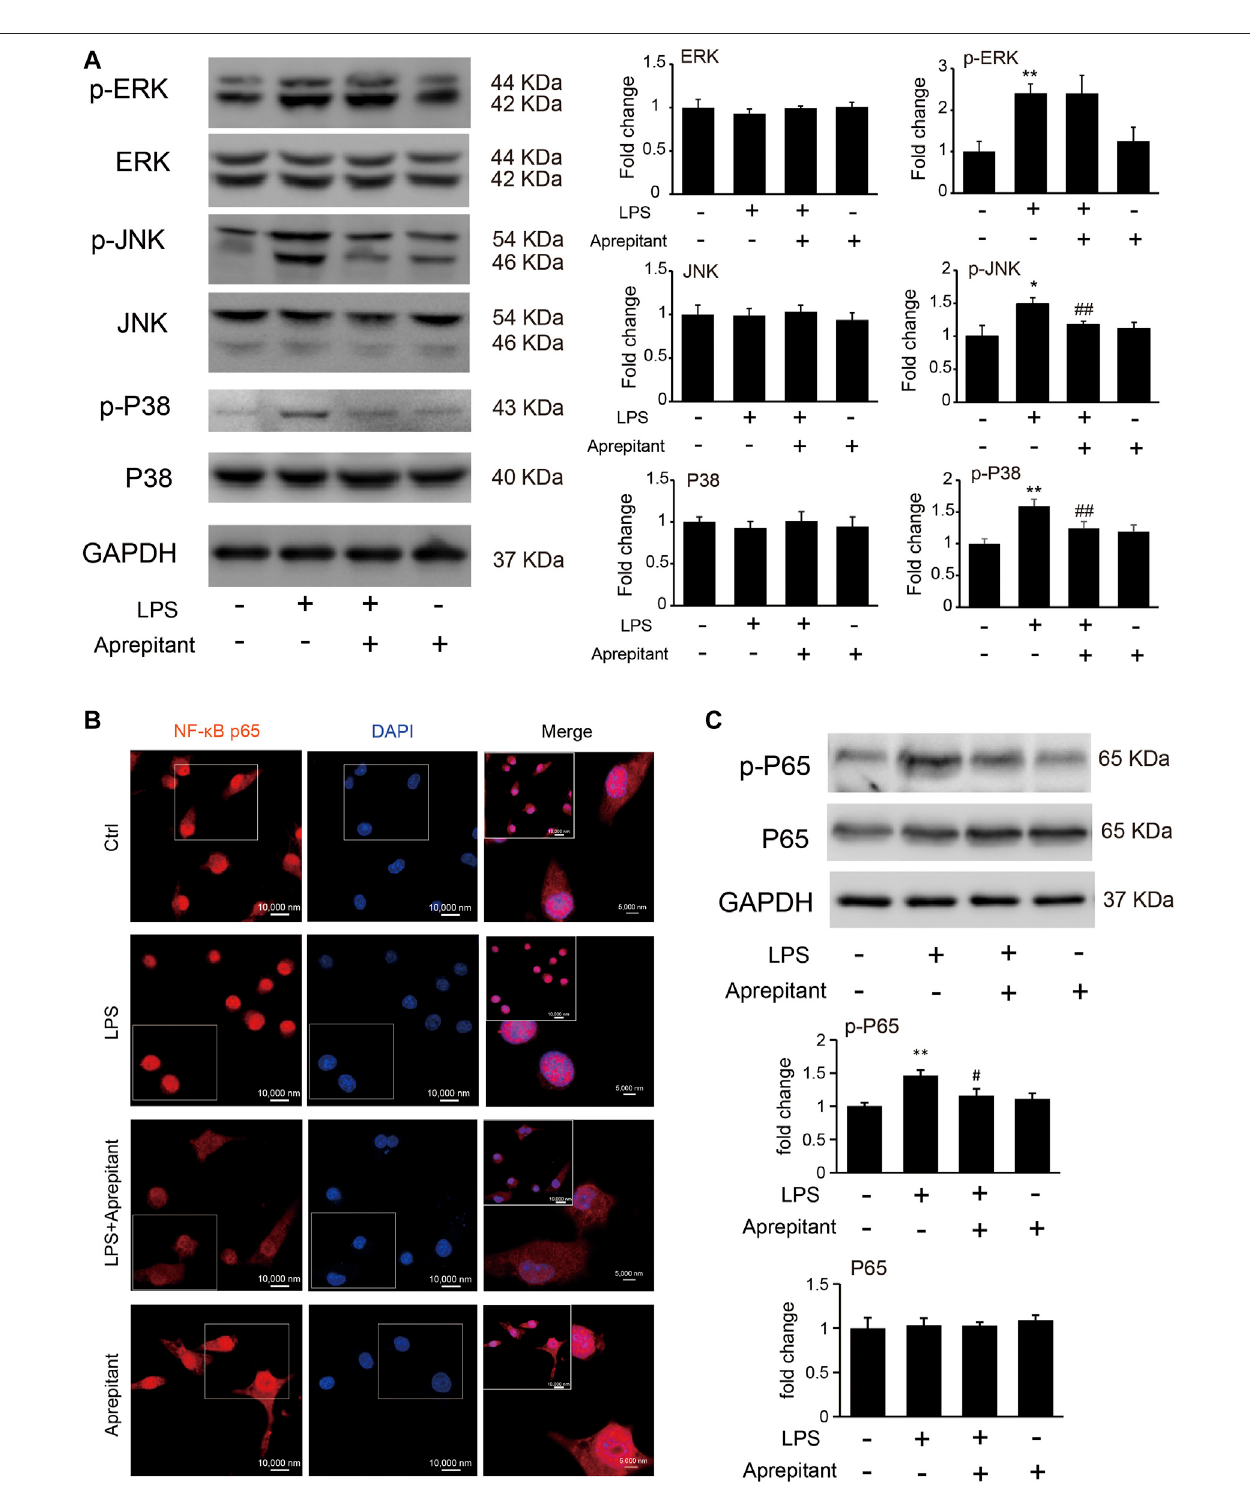
FIGURE4| Effectsofaprepitantonthephosphorylation ofMAPKandnucleartranslocationofNF- κ Bp65inBV-2microglia. (A) Theproteinandphosphorylationof ERK, JNK and p38 MAPK in BV-2 microglia. (B) Immuno fl uorescence was used to analyze NF- κ Bp65 nuclear translocation. (C) The phosphorylation and protein expressionofNF-kBp65inBV-2microgliawereassessedbywesternblotting( n (cid:1) 6).Dataareexpressedasmean ± SEM.One-wayANOVA,* p < 0.05,** p < 0.01versus control, # p < 0.05, ## p < 0.01 versus LPS.